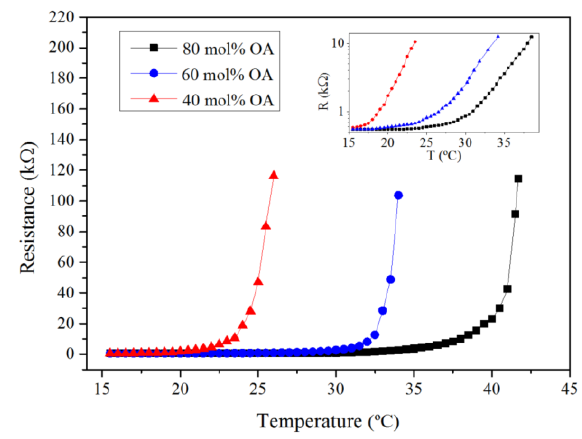
Figure 7. Thermal response of acrylate PTC composites.